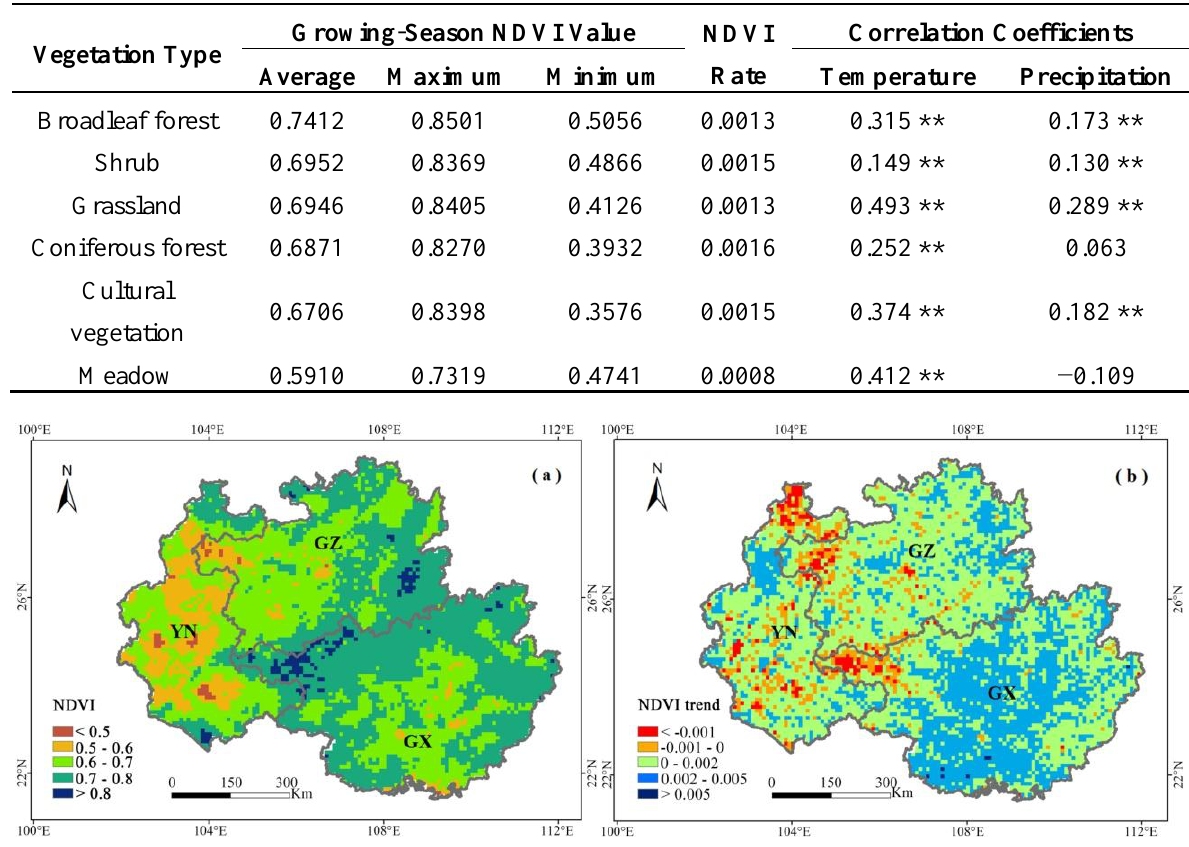
Table 1. Statistical characteristics of growing-season NDVI for different vegetation types